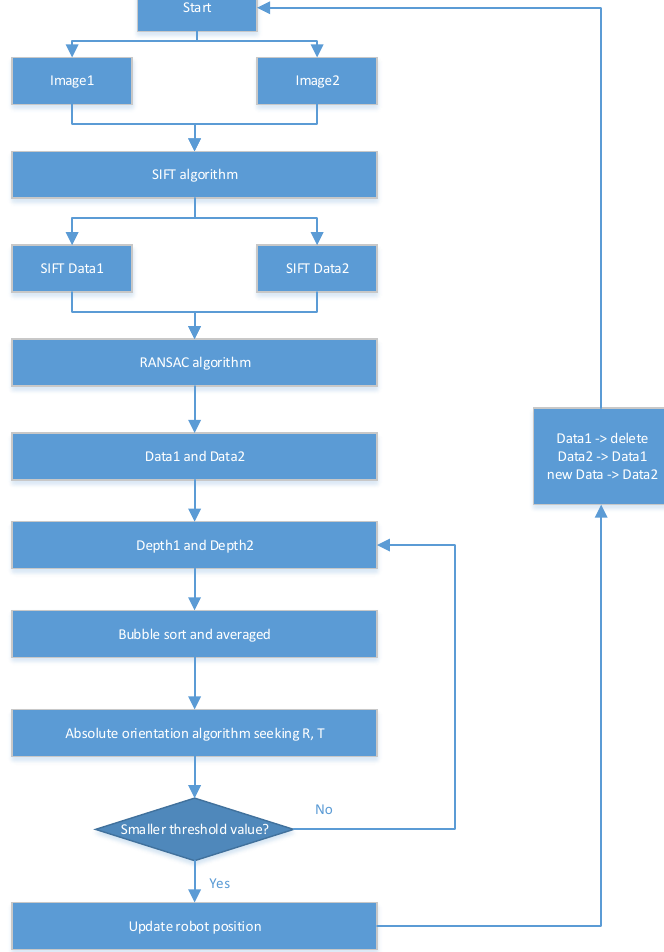
Figure 1. Flowchart of the robot self-localization method.